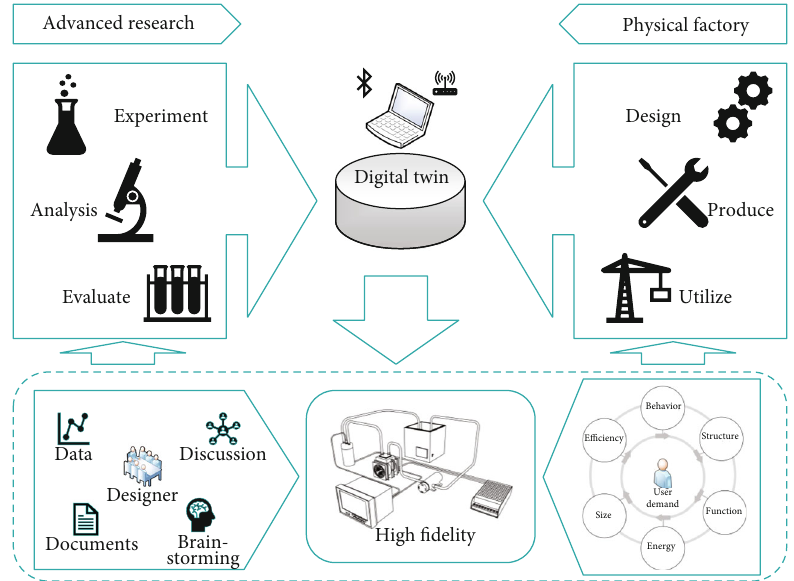
Figure 9: Correspondence between the digital model and real design object.